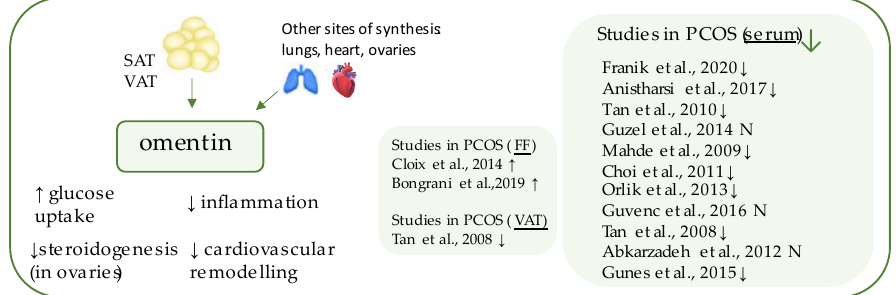
Figure 4. Role of omentin in the pathogenesis of insulin resistance and PCOS. List of the studies assessing nesfatin level in serum, follicular fluid (FF), and visceral adipose tissue (VAT) of the patients with PCOS. ↓ /N indicates that concentration level of omentin was decreased/unchanged in PCOS individuals ( p < 0.05) .